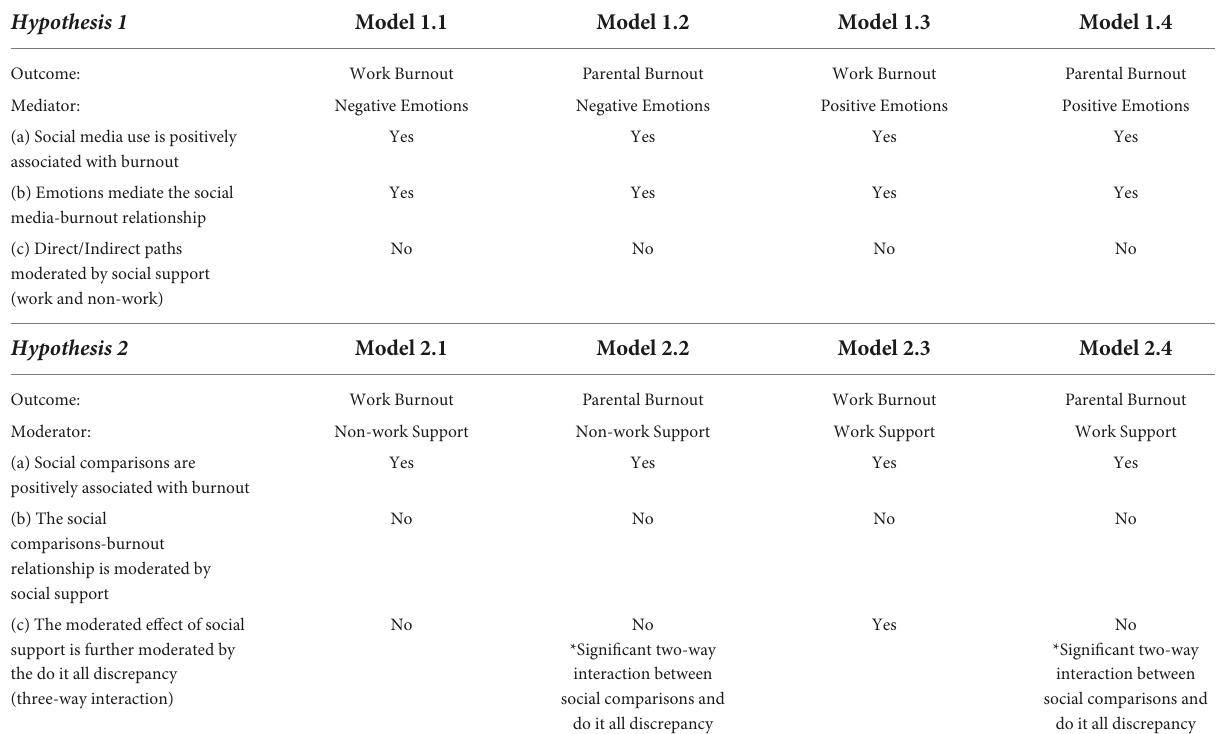
TABLE 2 Summary of results of hypothesis